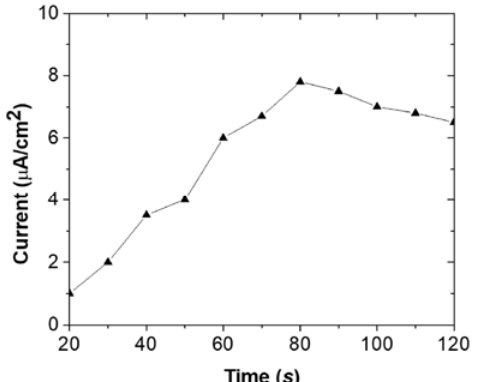
Fig. 10. Effect of accumulation time on the electrochemical response of butachlor at Pd@MWCNTs; accumulation potential –1.13 V; pulse amplitude 30 mV; scan rate 50 mVs -1 .